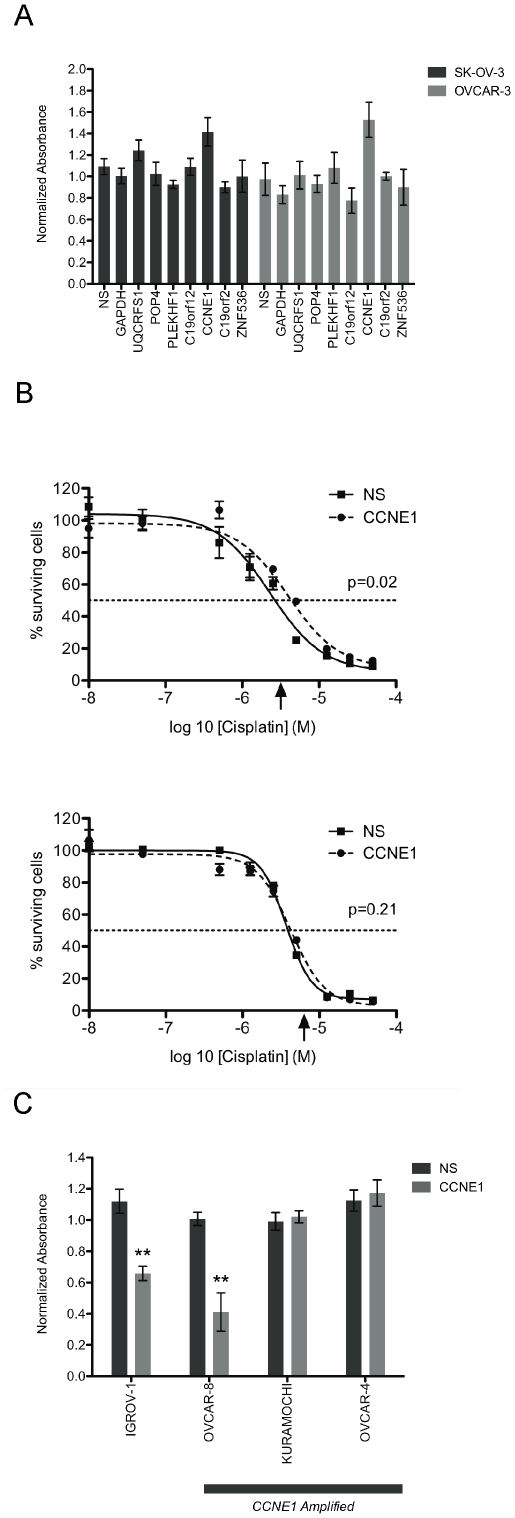
Combined siRNA knock-down and cisplatin treatment in ovarian tumor cell lines.(A) Cell viability after transfection with individual siRNAs and cisplatin treatment normalized to cisplatin-treated control cells without siRNA. Cisplatin dose of 3 µM or 6 µM was used for OVCAR-3 and SK-OV-3 cells respectively. Average normalized absorbance (490 nm) from three independent MTS assays (triplicate wells per condition) and SEM plotted (n = 3). (B) Cisplatin dose response after transfection with CCNE1 or non-silencing siRNA in OVCAR-3 and SK-OV-3 cell lines. Arrow indicates drug treatment dose used in initial screen; p-value indicates significance of difference between fitted curves. Average normalized MTS assay absorbance to cells without cisplatin treatment, SEM and four-parameter fitted Hill slope plotted (n = 3 for each drug concentration). (D) Cell viability after transfection with CCNE1 or NS siRNAs and cisplatin treatment normalized to cisplatin-treated no siRNA control cells for each cell line. Statistical significance calculated by comparison to NS siRNA, cisplatin-treated cells in the same cell line. Average normalized absorbance from MTS assay and SEM plotted (n = 3). See Table S4 for cisplatin treatment doses.